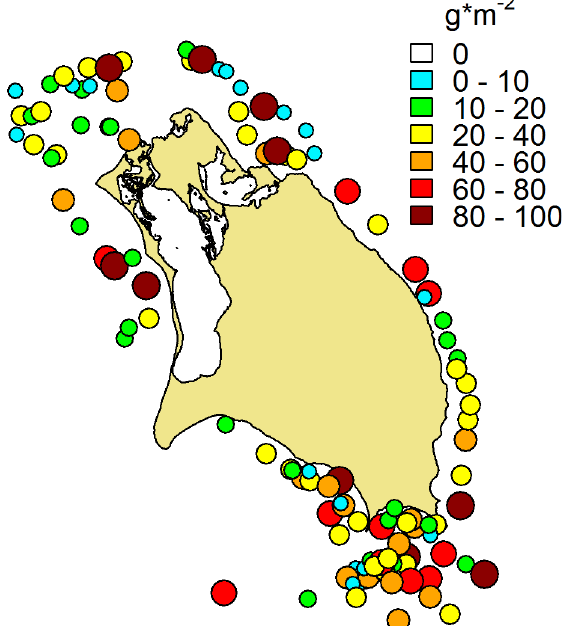
Fig 4. Total fish biomass. Spatial distributionof the total biomass of fish communitiesaroundBarbuda. Colors and sizes of symbols indicate bins of biomass density, in units of g m -2 .